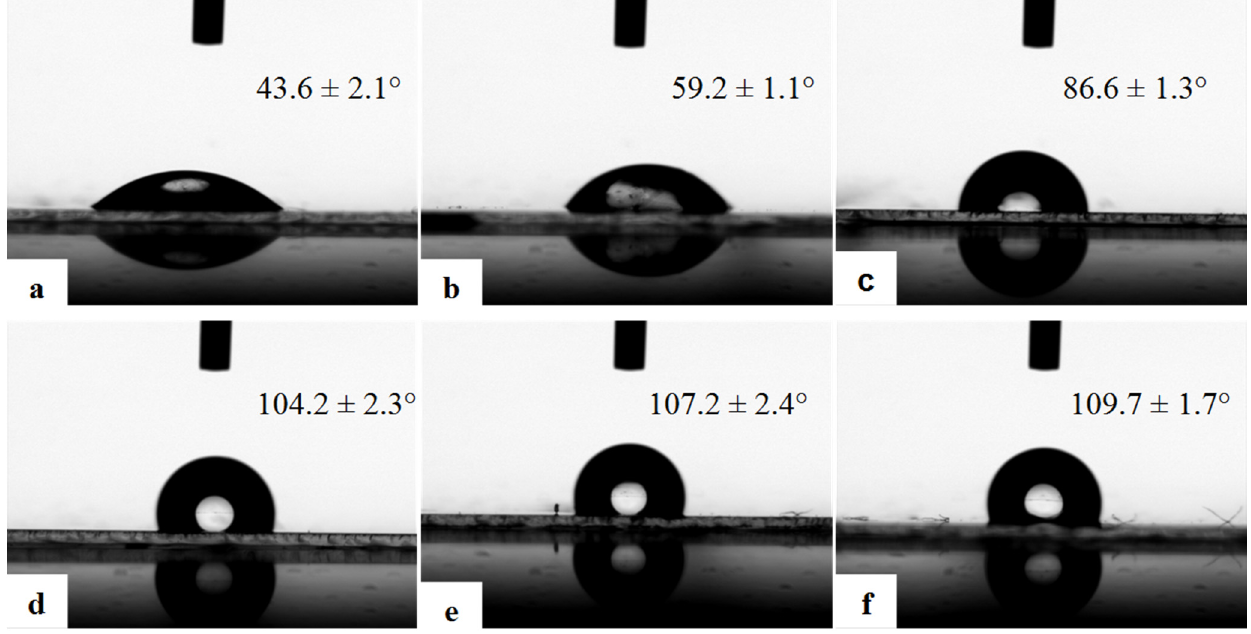
Figure 5. The water contact angle photos of the smooth polymer film spin-coated from different concentrations of the polymer solutions: ( a ) 0.08%; ( b ) 0.1%; ( c ) 0.2%; ( d ) 0.4%; ( e ) 0.6%; and ( f )